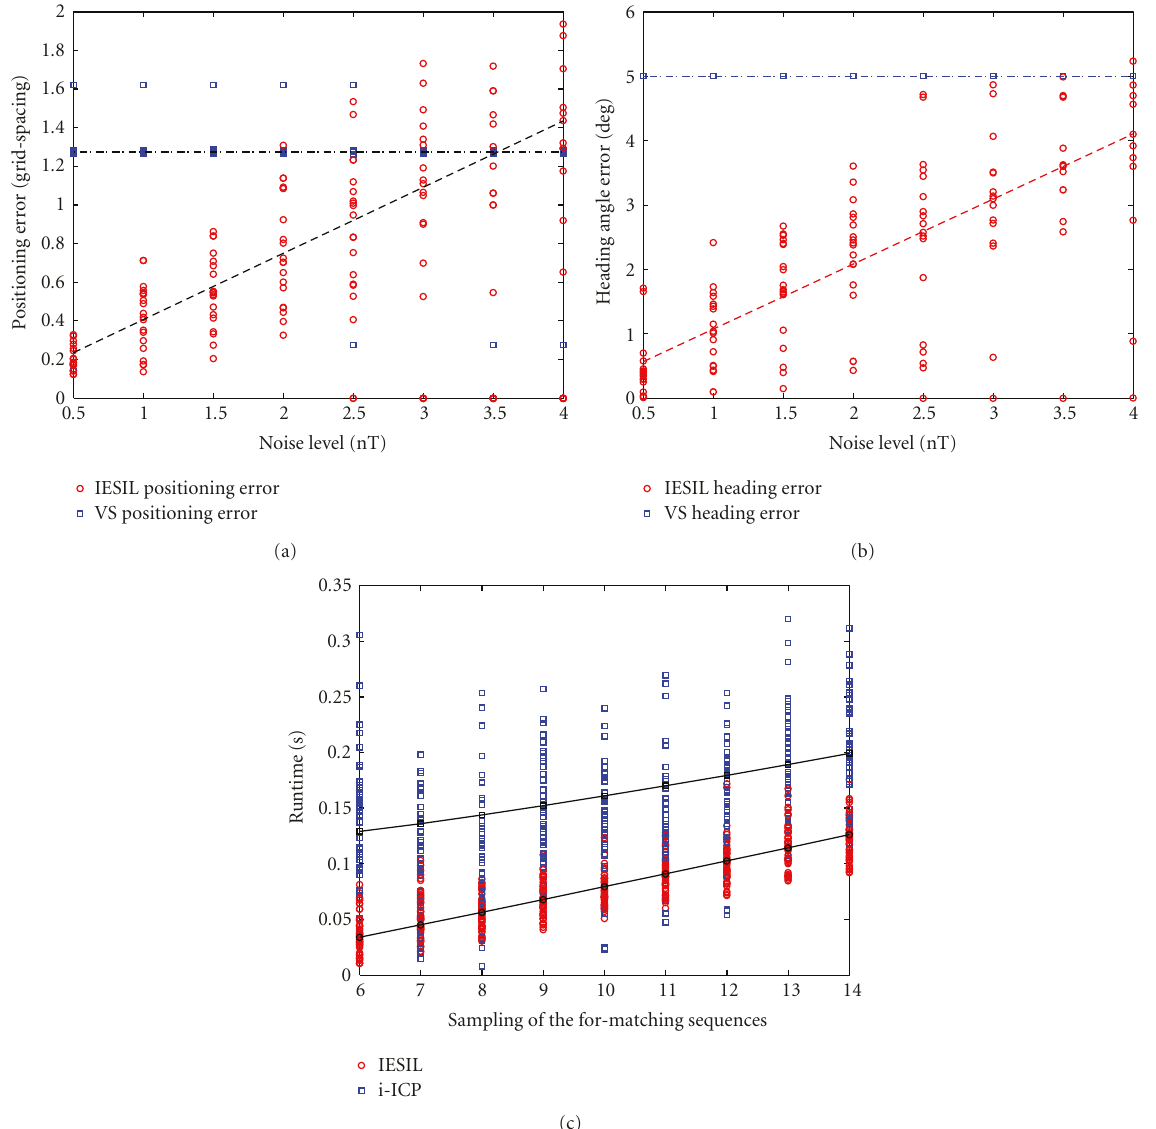
Figure 12: Performance comparisons: (a) positioning deviation, (b) orientating deviation, and (c) positioning